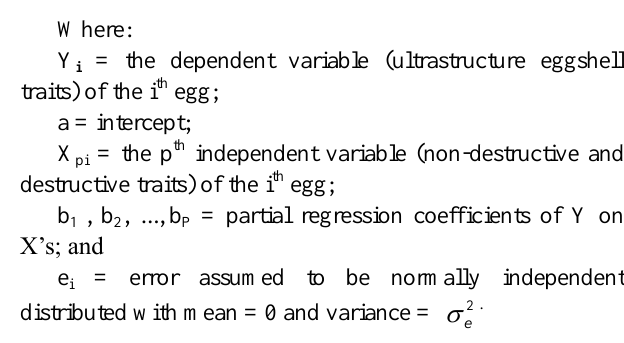
Table 1. Descriptive statistics for the traits describing non-destructive, destructive and eggshell ultrastructure properties from 120 Fayoumi eggs Trait Mean Coefficient of variation (%) Minimum Maximum Non-destructive traits Egg weight (mg)